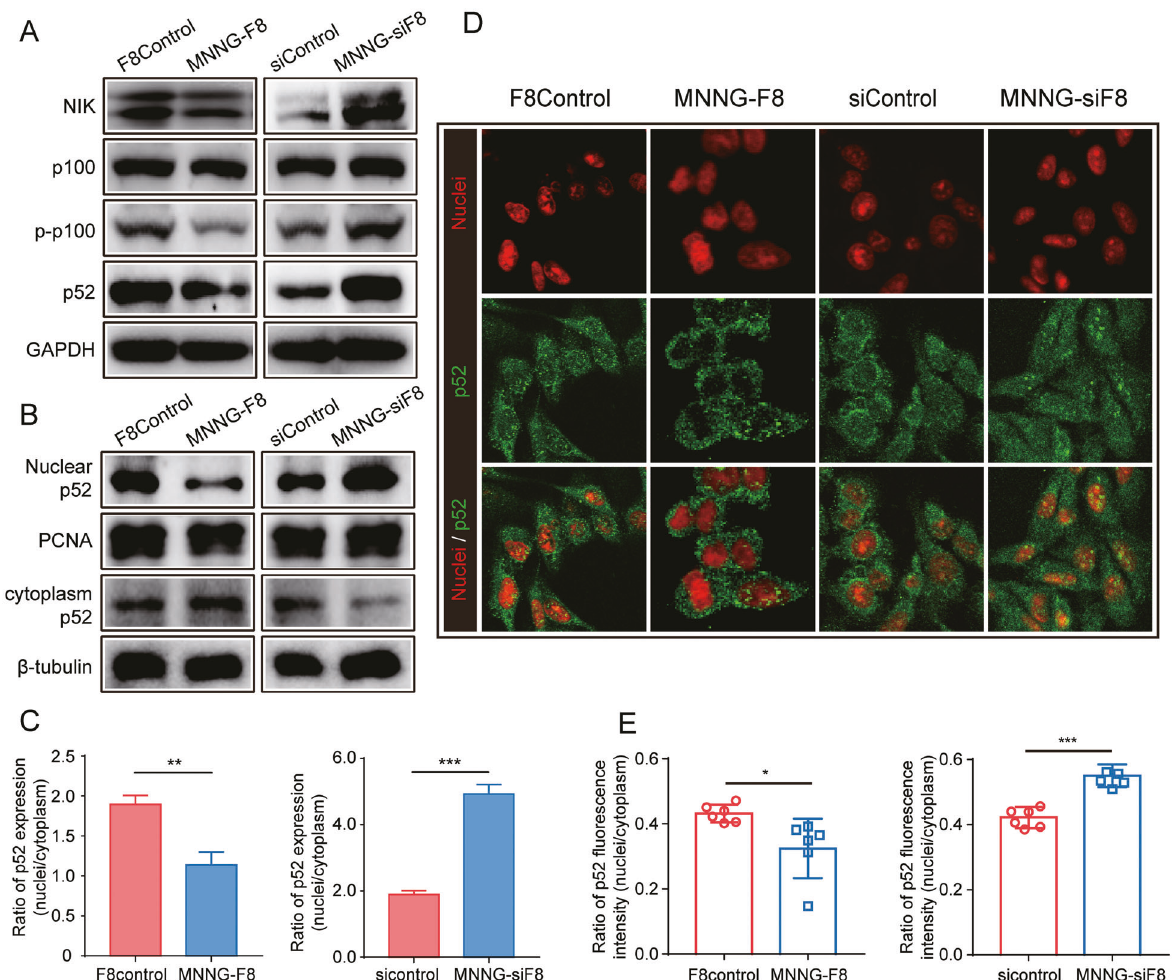
Fig. 6 Knockdown of FUT8 in OS cells in vitro activates TNF/NF- κ B2 signaling pathway. A Western blot of proteins in a NF- κ B2 signaling pathway show that this pathway was activated in MNNG-siF8 cells but inhibited in MNNG-F8 cells. B Analysis of p52 translocation in OS cell lines. Western blot probed for both in nuclear p52 and cytoplasmic p52. C Quantitation of ratio of nuclear p52 to cytoplasmic p52 expression. Mean ± SD ( N = 3) ratio expression in MNNG-siF8 cells was higher, compared to controls, and lower in MNNG-F8 cells. Relative expression